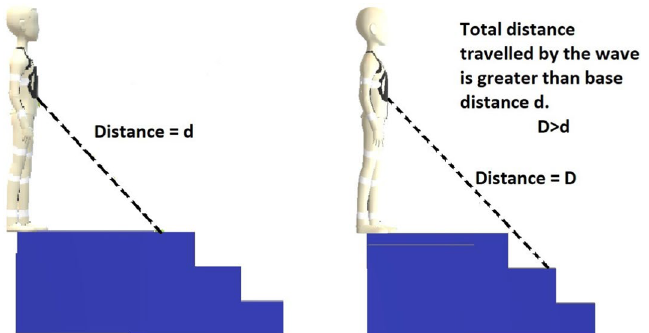
Fig. 7 Slope and downward steps